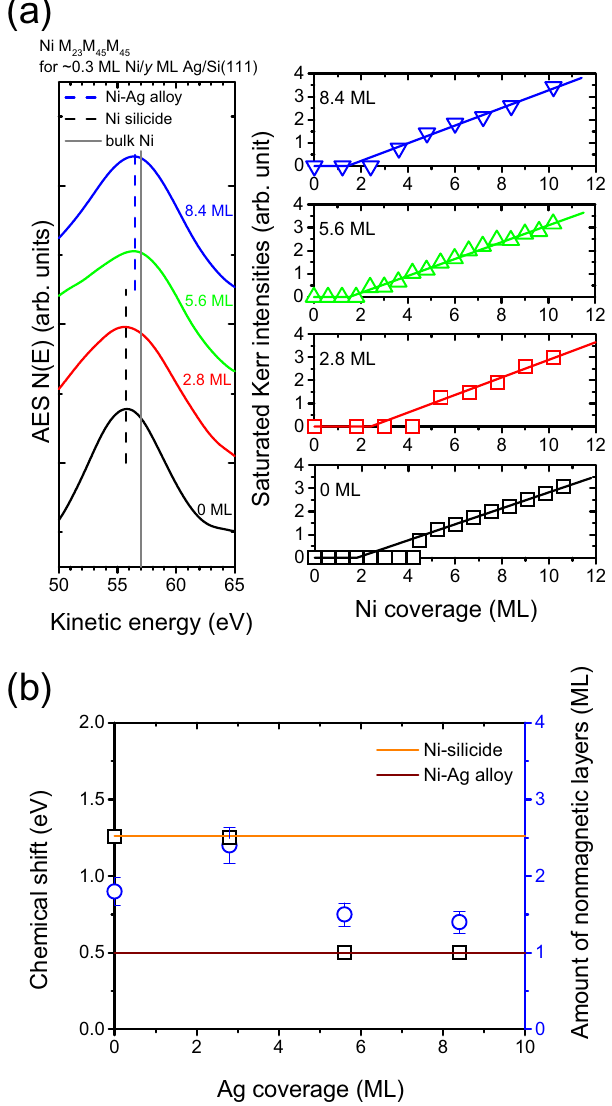
Figure 4. ( a ) Left panel: Auger spectra near the Ni M 23 M 45 M 45 transition line for approximately 0.3 ML of Ni on Si(111) and Ag/Si(111) with an Ag layer thinner than 8.4 ML; right panel: saturated Kerr intensities versus Ni coverage for Ni/Ag/Si(111) with the Ag inserting layers being 0, 2.8, 5.6, and 8.4 ML. ( b ) The chemical shift (black squares) and the amount of nonmagnetic layers (blue circles) versus the Ag